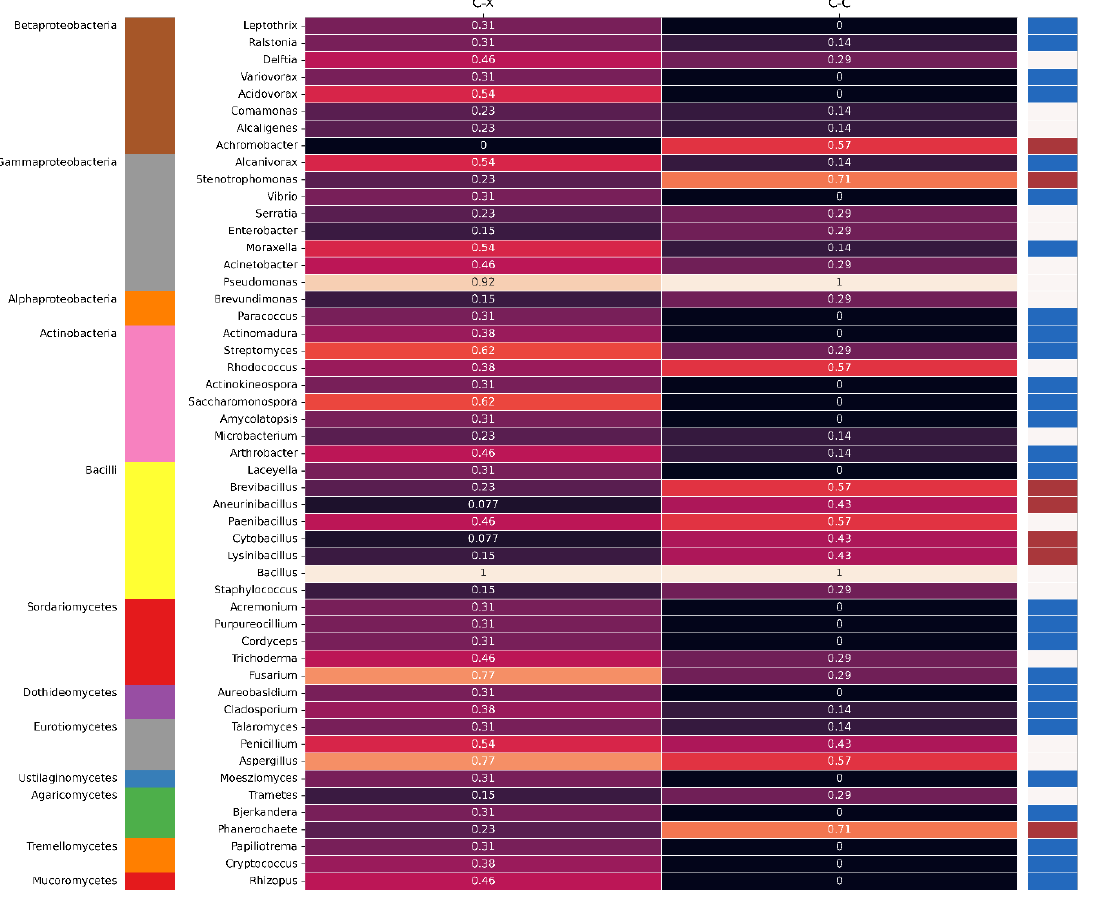
Figure 4. The heatmap shows the group level proportion plastic types reported for 51 selected genera. The left-most vertical bar shows the class of genus and the right-most bar shows the group association with individual rows if applicable.